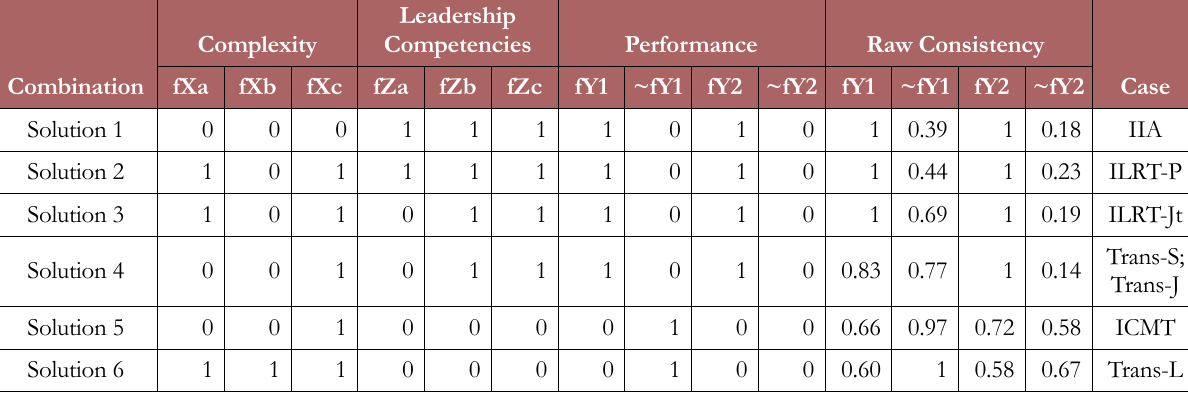
Table 4. The Final Truth Table Table 4 identifies the combination of complexity and leadership competence in the “high” [1] and “low” [0] conditions on short-term high performance (Y1); short-term low performance (~Y1); long-term high performance (Y2); and long-term low performance (~Y2). For example, in the ILRT-Jt case (combination solution 3), the fuzzy scores (from Table 3) for the conditions of structural (fXa), social (fXb), and emergent (fXc) complexities have been determined to be 0.68, 0.29, and 0.93 respectively. Only the structural (fXa) and emergent complexity (fXc)